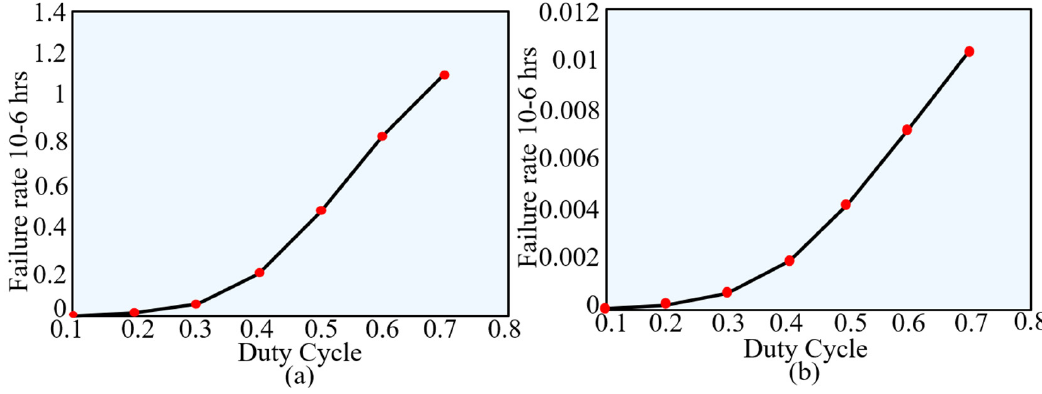
Figure 11. Failure rate ( a ) Switch; ( b )